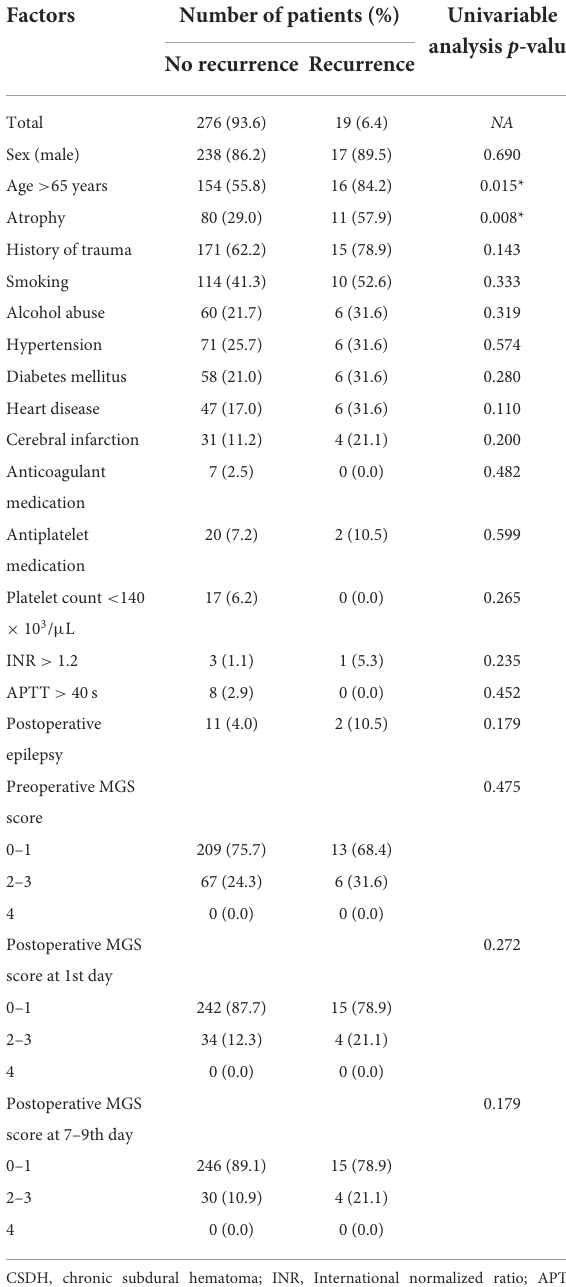
TABLE 1 Clinical characteristics of patients with CSDH ( n =